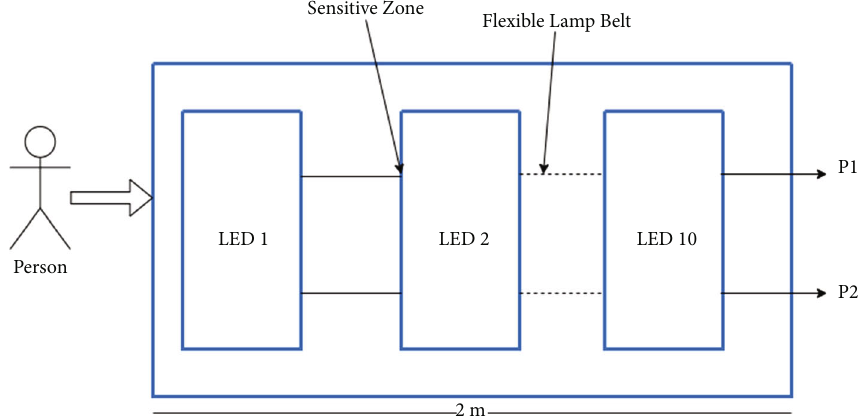
Figure 1: Structure of FOPS smart carpet for gait